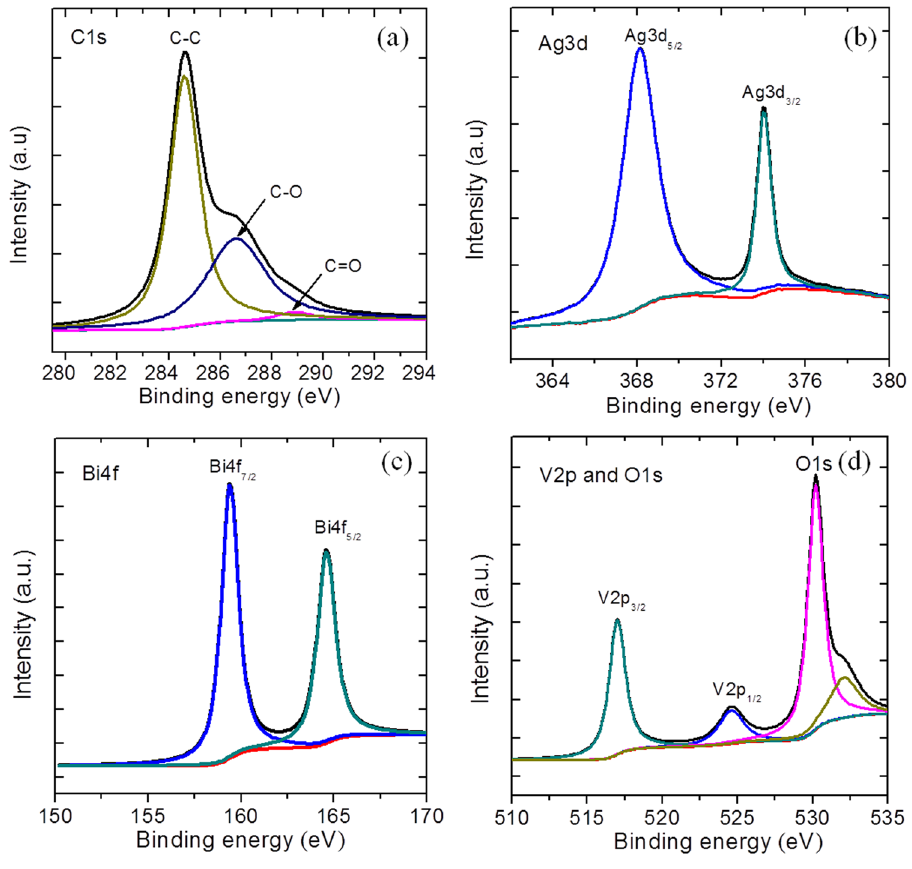
Figure 2. XPS spectra of the BiVO 4 /Ag2%/rGO sample ( a ) C1s, ( b ) Ag3d, ( c ) Bi4f, ( d ) V2p, and O1s,